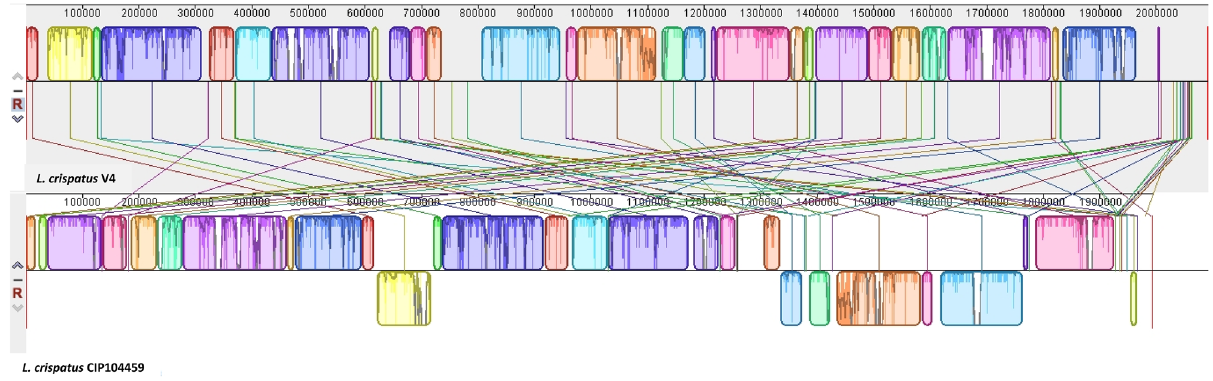
Figure 2. Comparative genome synteny between Lactobacillus crispatus V4 and Lactobacillus crispatus CIP104459. Homologous regions are identified as locally collinear blocks (LCBs). White regions correspond to sequences that are not aligned and probably contain sequence elements specific to a particular genome. Flipped blocks indicate a reverse complement (inverse)